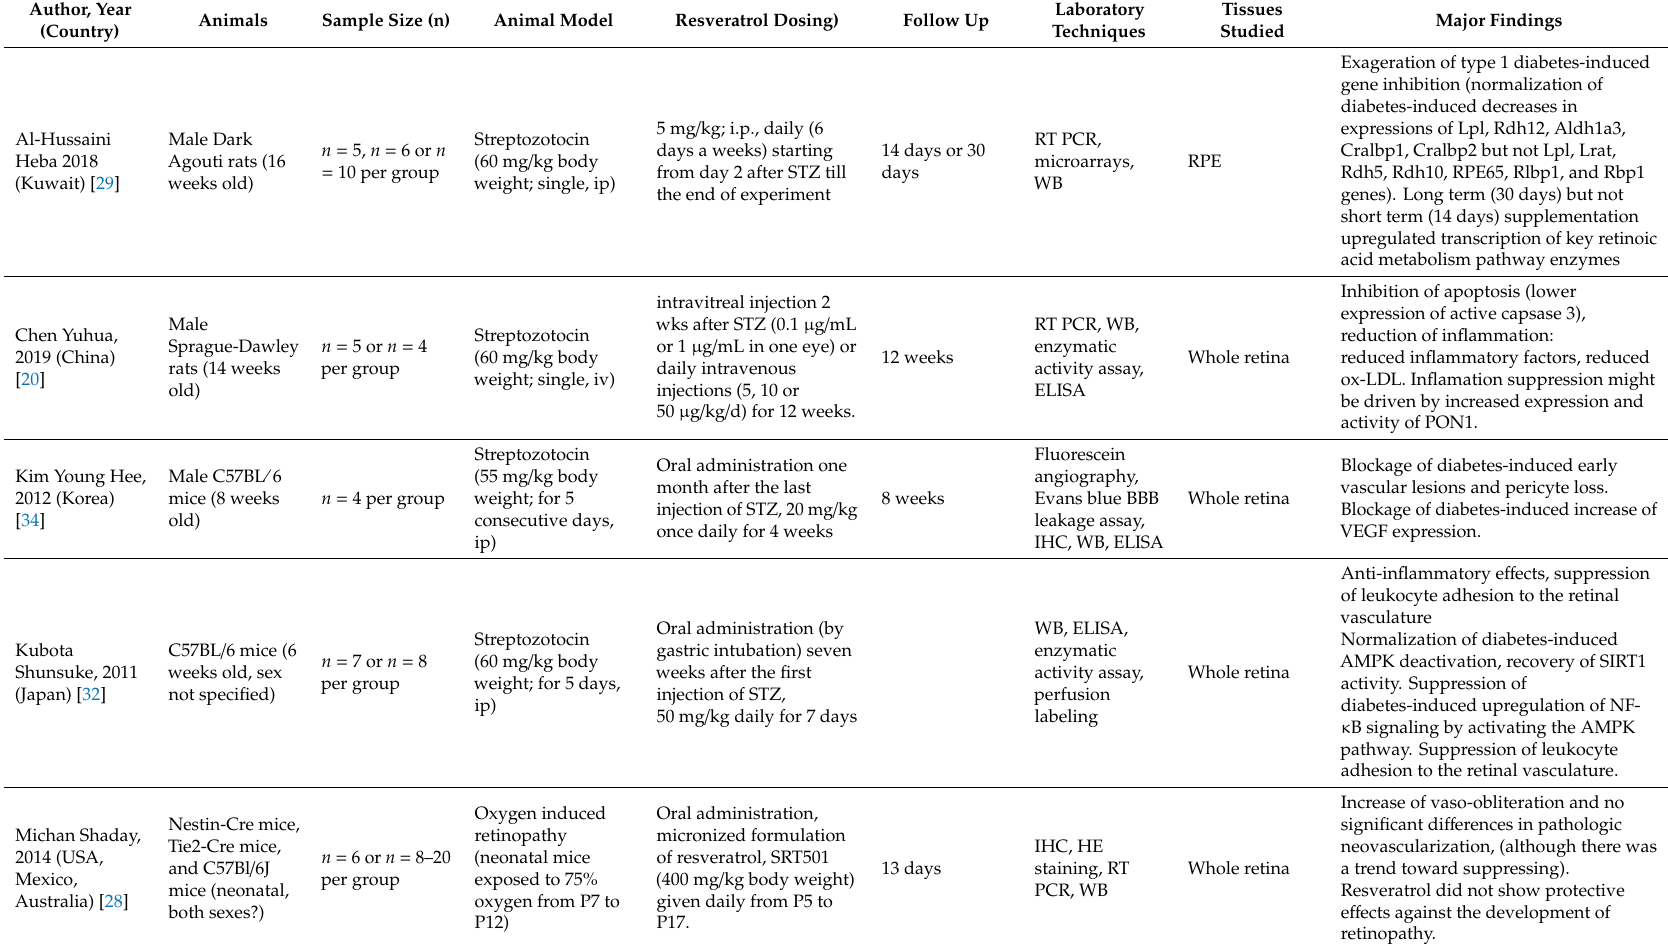
Table 3. In vivo studies on resveratrol e ff ect in animal models of diabetic